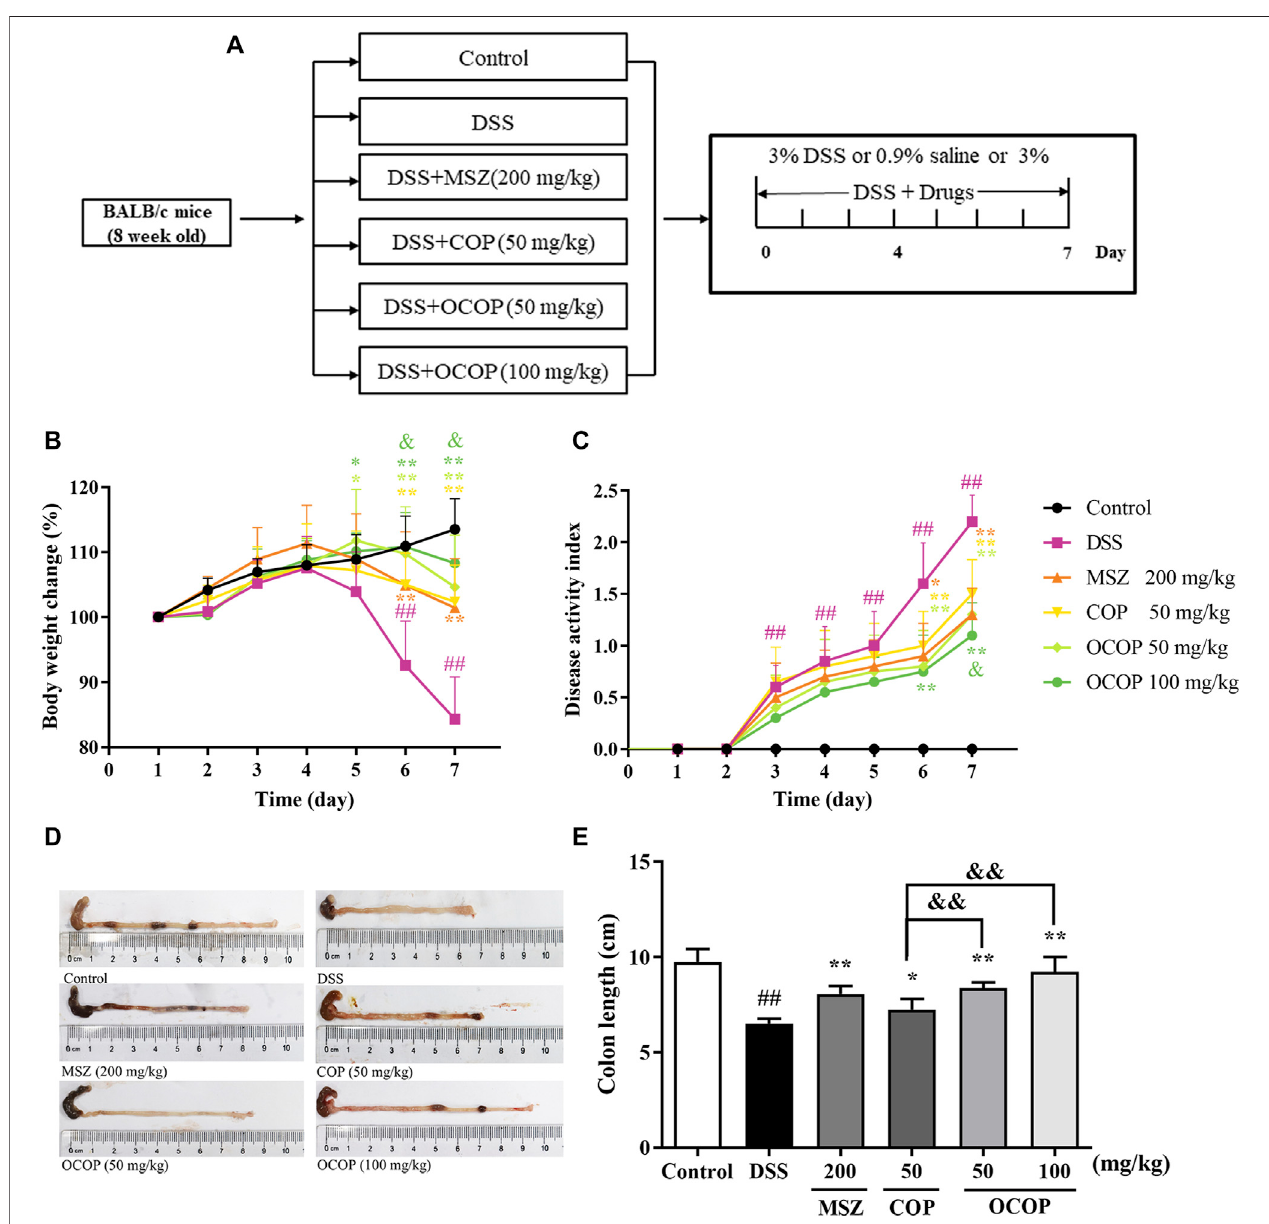
FIGURE2| Effects ofOCOP(50and 100 mg/kg) andCOP(50 mg/kg) ondailybodyweightchanges,anddisease activityscoreofDSS-inducedcolitismice.After DSS challenge, treatments were administered once a day by intragastric gavage for a week (A) Schematic diagram of the experiment design (B) Daily body weight changes (C) DAI score index (D) Macroscopic photographs of colon lengths (E) The length of colon. Data are expressed as the means ± SD (n (cid:2) 8 – 10). # p < 0.05, ## p < 0.01 vs. control group; * p < 0.05, ** p < 0.01 vs. DSS group; & p < 0.05, && p < 0.01 vs. COP